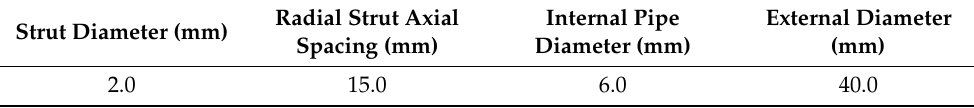
Table 1. POCS geometrical